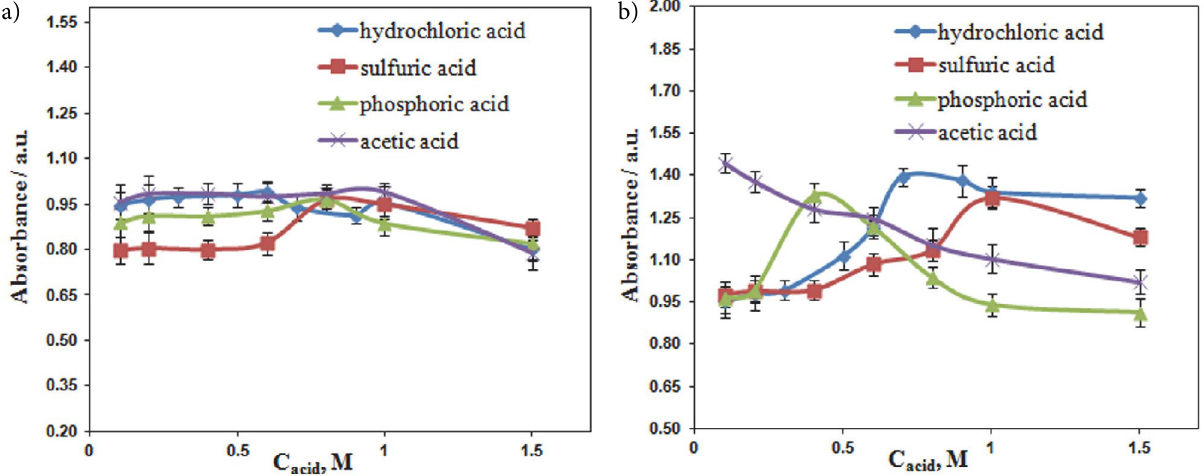
Fig. 2. Effect of nature and concentration of acid on the a) SA and b) STZ diazonium salt formation and the product of its interaction with the AM. C SA = 2.0 . 10 –4 M, C STZ = 2.0 . 10 –4 M, C NaNO = 2.0 . 10 –3 M, C AM = 5.0 . 10 –5 M, n = 5. 2